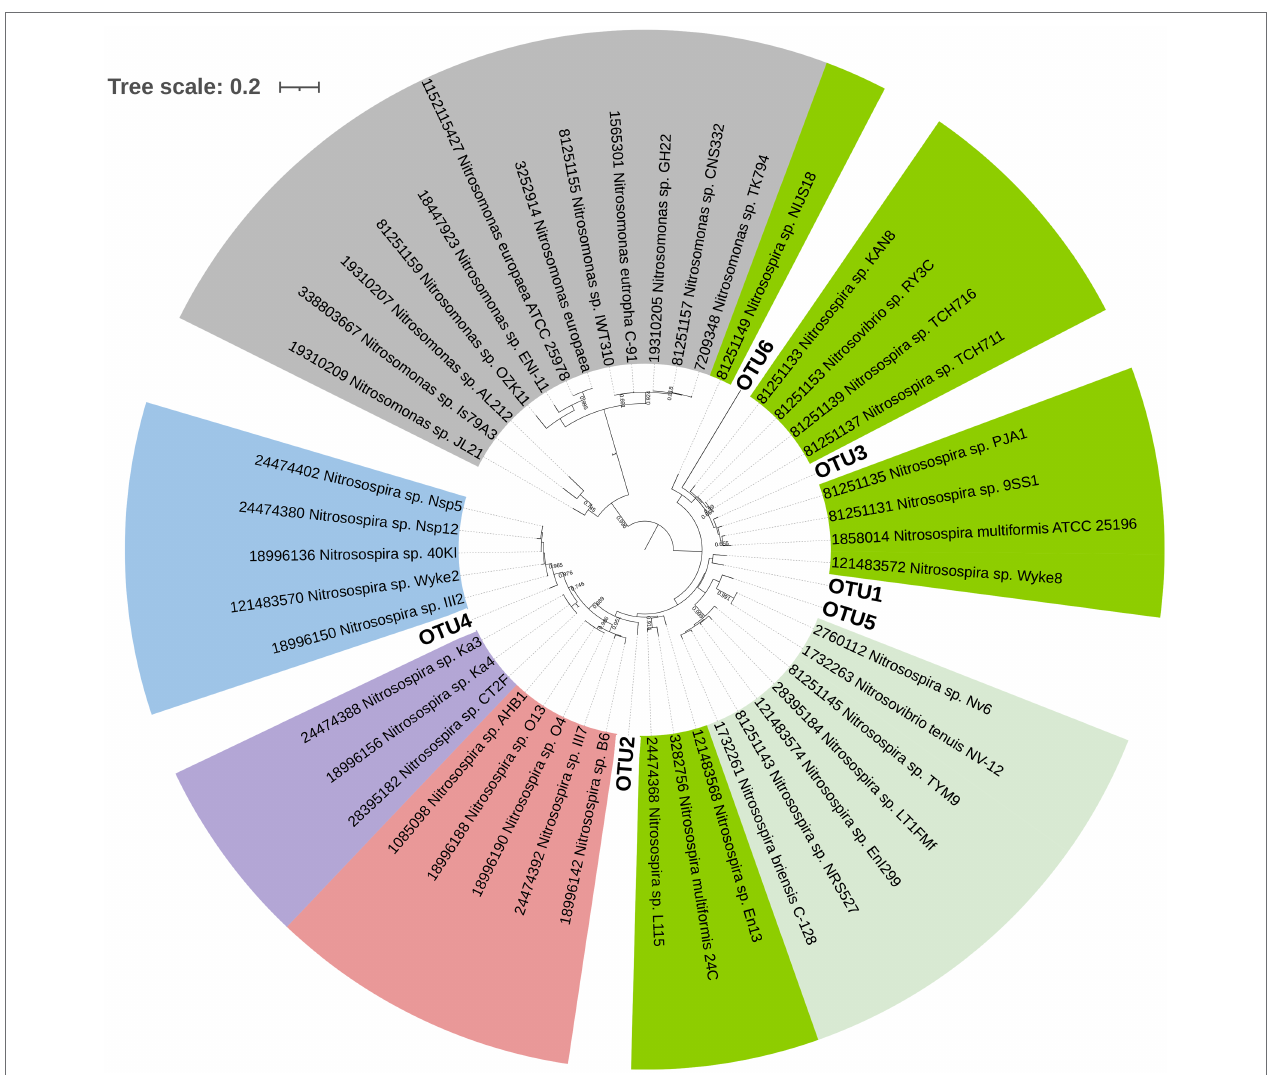
FIGURE 5 | Phylogenetic tree of AOB with the six OTUs obtained in this study after clustering ASVs at 90% identity (bold letter). The different Nitrosospira clusters commonly found in soil are indicated in colours (light blue: cluster 0; light purple: cluster 4; light red: cluster 2; light green: cluster 3b and green: cluster 3a). Nitrosomonas lineage is shown in gray. The evolutionary history was inferred by using the Maximum Likelihood method based on Hasegawa-Kishino-Yano model (lowest Bayesian Information Criterion index, BIC) in MEGAX. The tree with the highest log likelihood ( − 4633.71) is shown. Bootstrap values (>65%) are shown at branch nodes. A discrete Gamma distribution was used [five categories (+G, parameter = 0.2979)]. The tree is drawn to scale, with branch lengths measured in the number of substitutions per site. This analysis involved 50 nucleotide sequences. All positions with less than 95% site coverage were eliminated (partial deletion option). There were a total of 410 positions in the final dataset. iTOL tool was used for tree